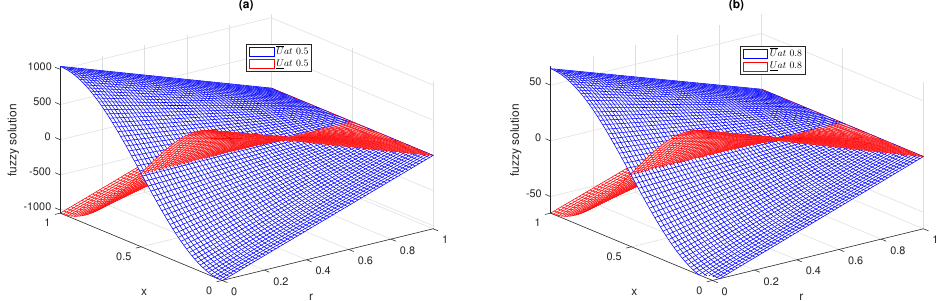
Figure 3 is the 3D plot showing the upper and lower portions of the fuzzy solution for the fractional- order fuzzy heat equation of Example 2 at x 1 = 0.8, x 2 = 0.5 , and at various fractional orders of θ . Figure 4 shows the behavior of the upper and lower portions of the fuzzy solution in two-dimensional format for the fractional-order heat equation of Example 2 at x 1 = 0.8, x 2 = 0.5, τ = 0.5 , and at various fractional orders of θ and r ∈ [ 0, 1 ] . Like for the first example, the curve in both the 2D and 3D cases for the lower and upper portions begins from zero and continues to positive and negative values. This is also due to (cid:101) k ( r ) = [ k ( r ) , k ( r )] = [ 1 − r , r − 1 ] , k ( r ) = 1 − r , r ∈ [ 0, 1 ] providing the upward portion or positive fuzzy solution, while k ( r ) = [ r − 1 ] , r ∈ [ 0, 1 ] provides the lower portion or negative fuzzy solution.